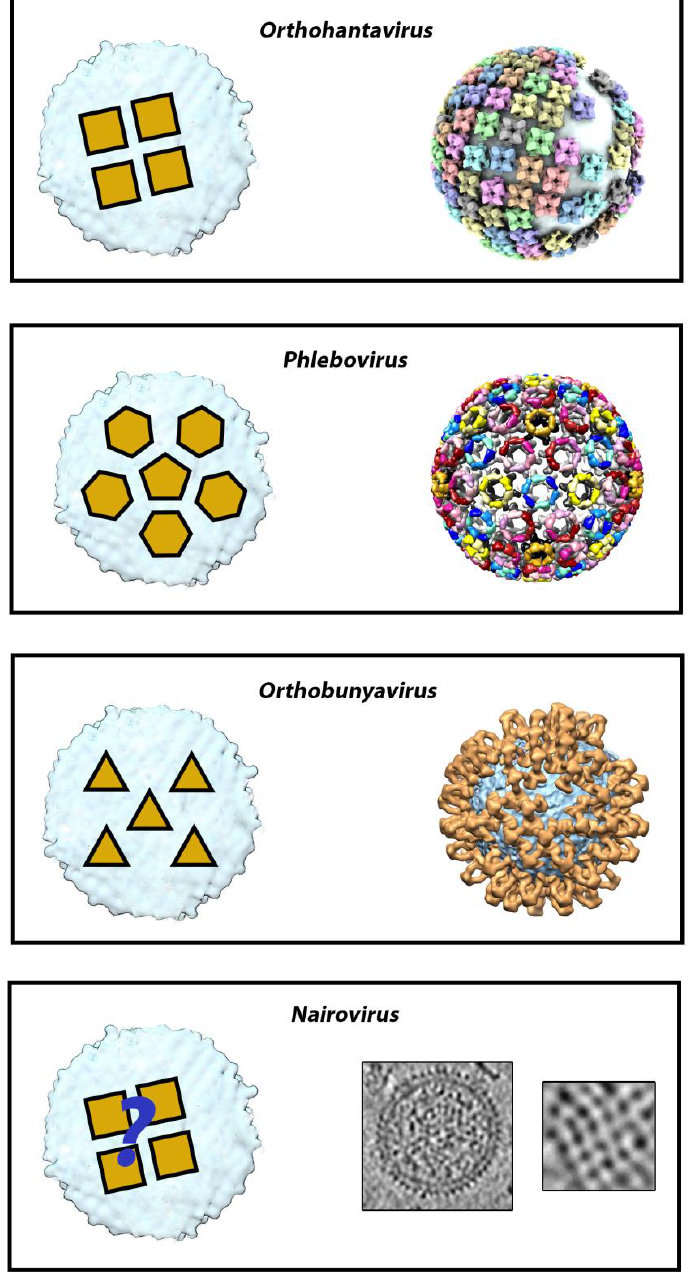
Figure 2. Architectures of the outer lattice and spike organization of orthohantavirus (Hantaviridae), phlebovirus (Phenuiviridae), orthobunyavirus (Peribunyaviridae) and nairovirus (Nairoviridae) (adapted from [12]). Orthohantavirus virions are pleomorphic and covered by a grid-like pattern formed by tetrameric spikes of Gn/Gc [13,14]. Reconstruction of a hantavirus particle obtained by fitting an Andes virus glycoprotein spike into a Tula virus reconstruction (PDB: 6ZJM). Each (Gn/Gc) 4 spike is displayed in a different color. Virions of phleboviruses display a T = 12 icosahedral lattice formed by 110 hexameric and 12 pentameric capsomers consisting in equimolar amounts of Gn and Gc [15]. Model of a Rift Valley fever virus particle (PDB 6f9b) from [2]. The surface of peribunyaviruses is decorated with tripod-like projections formed by Gn/Gc protomers [16]. Tomo- graphic reconstruction of a Bunyamwera virus particle from [12]. The structure of nairovirus virions has not been elucidated so far. They present a pleomorphic morphology similar to hantaviruses from the cryoEM study [17]. The cryoEM images are from